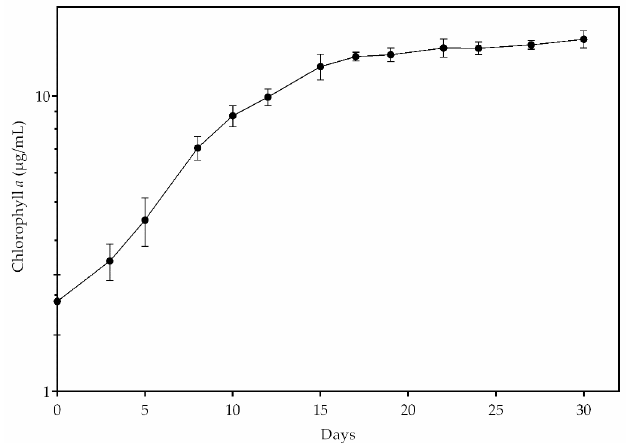
Figure 2. Growth of Stigeoclonium sp. B23 in standard medium based on the amount of chlorophyll a ( μ g/mL) at each harvest for 30 days. Data are the mean ± SD of three replicates.